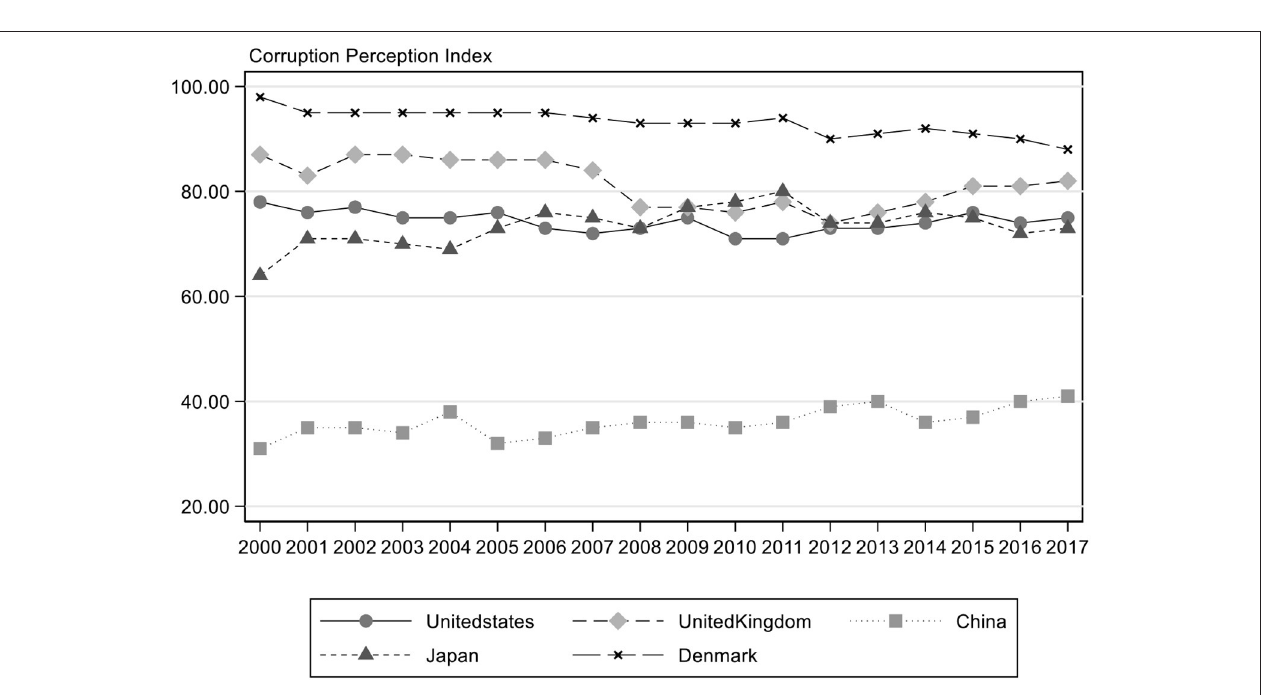
FIGURE 2 | Transparency international’s corruption perception index from 2000 to 2017. Source: Transparency international. by politics or become a rent-seeking tool for government officials. Many consumers also believe that utility operators have colluded with regulators to make excess profits (Stiglitz,